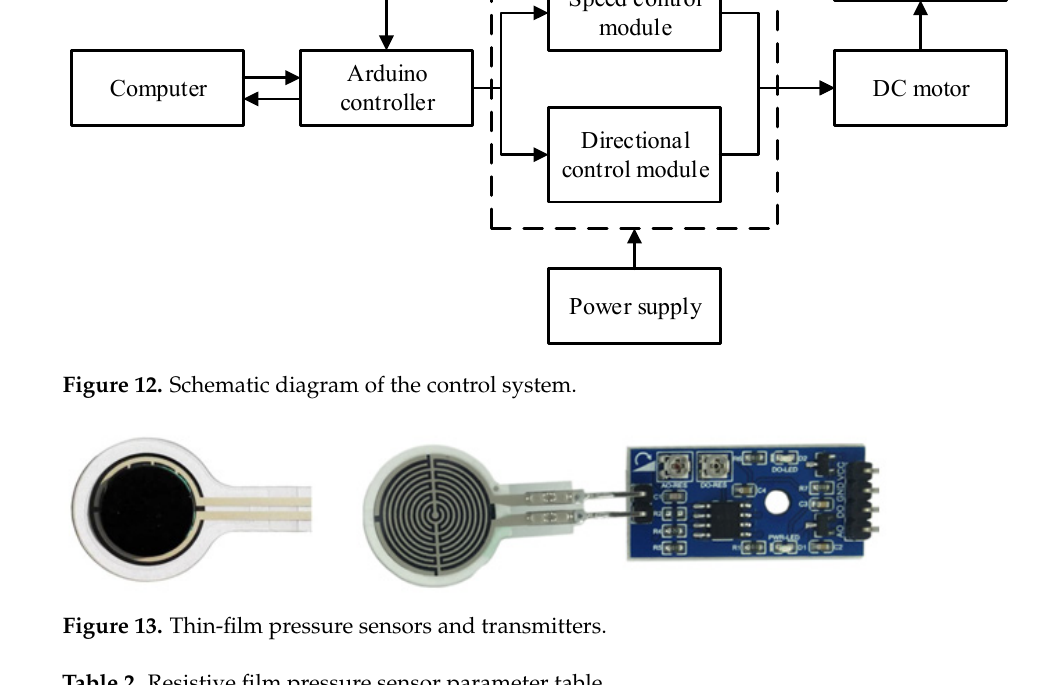
Figure 12. Schematic diagram of the control system.